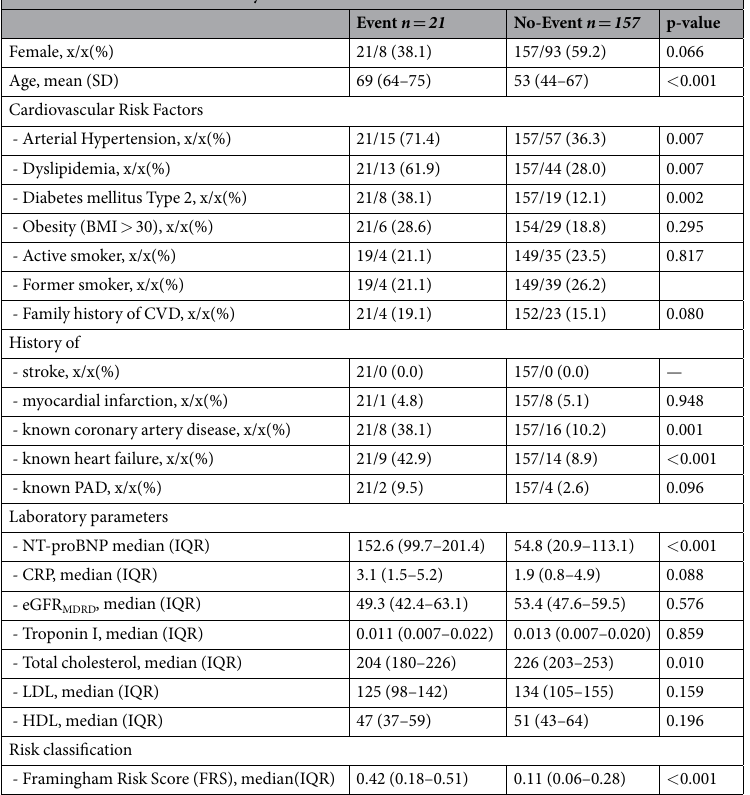
Table 1. Baseline characteristics of the derivation study cohort